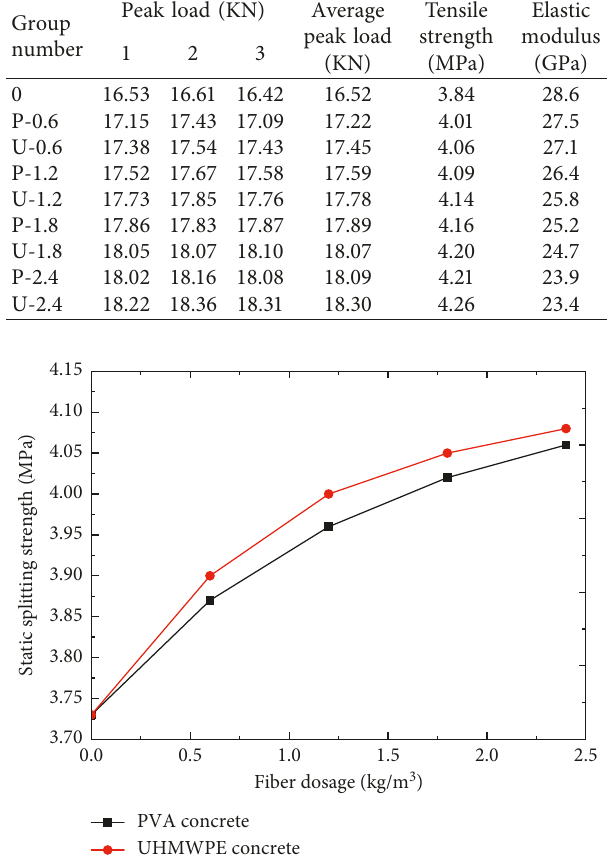
Figure 18: Relationship between the amount of different fiber concrete and the tensile strength of each